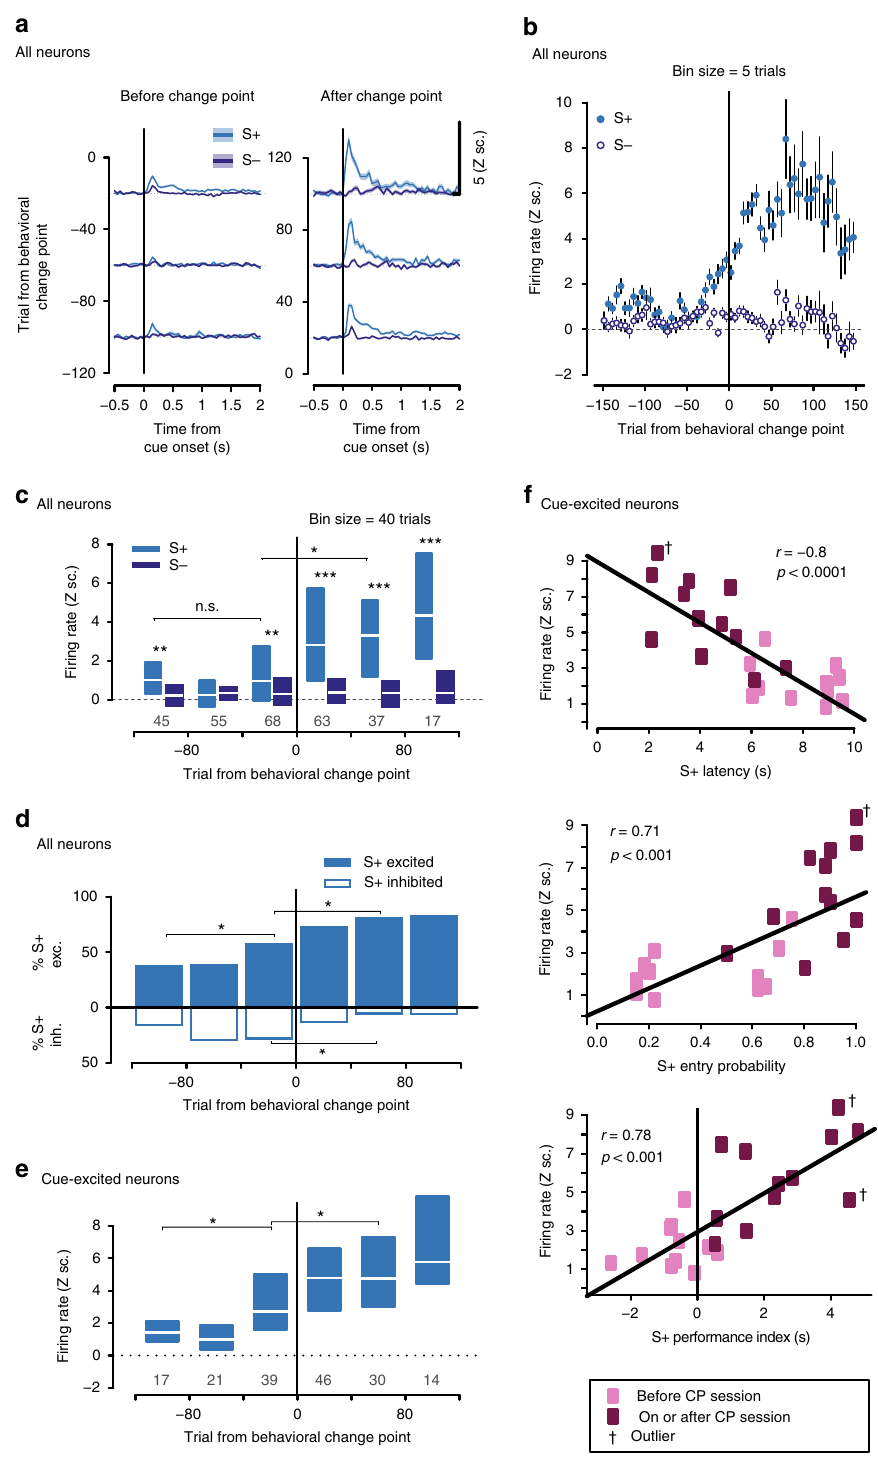
Fig. 2 NAc cue-evoked signals increase before CP and escalate with conditioned responding. a Firing rate in Z scores (Z sc.) around S + (light blue) or S − (dark blue) onset, trials aligned to change point (CP). Mean (line) ± SEM (shaded area). b Activity (mean ± SEM) 100 – 400 ms after S + (light blue) or S − (dark blue) onset around CP ( fi ve-trial bins). c Same as in b but median and interquartile ranges are shown in 40-trial bins. Numbers indicate sample size. Firing after S + was higher than after S − on most bins. S + -evoked excitations increased after CP (* p < 0.05; ** p < 0.01; *** p < 0.001, Wilcoxon). d The proportion of cue-excited neurons (solid blue) began to increase before CP. It continued to increase while the proportion of cue-inhibited neurons (white) declined (* p <0.05, Fisher). e Same as in c but for cue-excited neurons only. S + -evoked excitations began to increase before CP. f Activity in the 100 – 400ms post-S + window strongly correlates with S + latency (top), S + entry probability (middle), and S + performance index (bottom) (*** p < 0.001, Pearson). Sessions before/after CP are shown in light/dark purple,